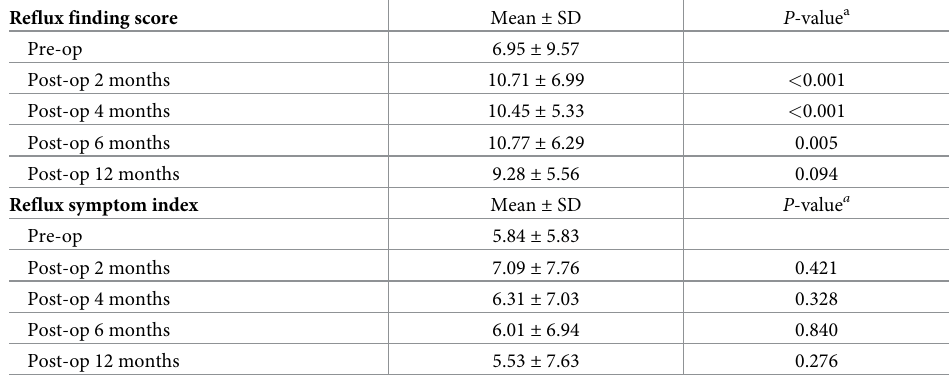
LPRD. In 25 patients with LPRD preoperatively, the RFS score increased significantly at two months after surgery and decreased to the preoperative level four months postoperatively. The RSI scores did not change significantly before and after surgery (Table 3). In the subgroup of 70 patients without LPRD, 17 patients met the criteria of LPRD by RFS or RSI at least one more time after surgery. The RFS scores increased at two, four, and six months after surgery and decreased to the preoperative level 12 months postoperatively. The RSI scores did not dif- fer before and after thyroidectomy (Table 3).